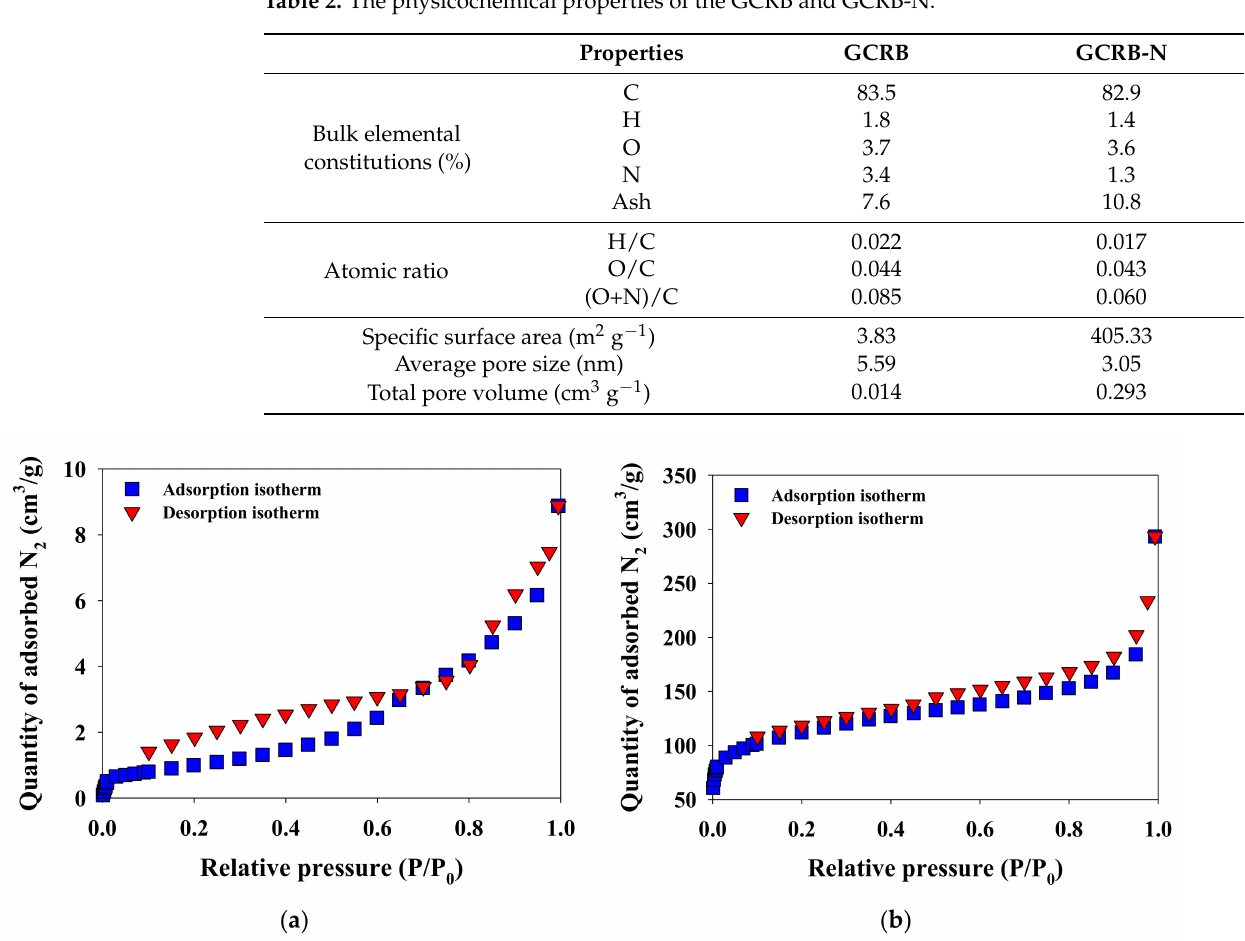
Figure 2. The N 2 adsorption/desorption isotherms of the ( a ) GCRB and ( b ) GCRB-N (at 77.3 K in the relative pressure range of